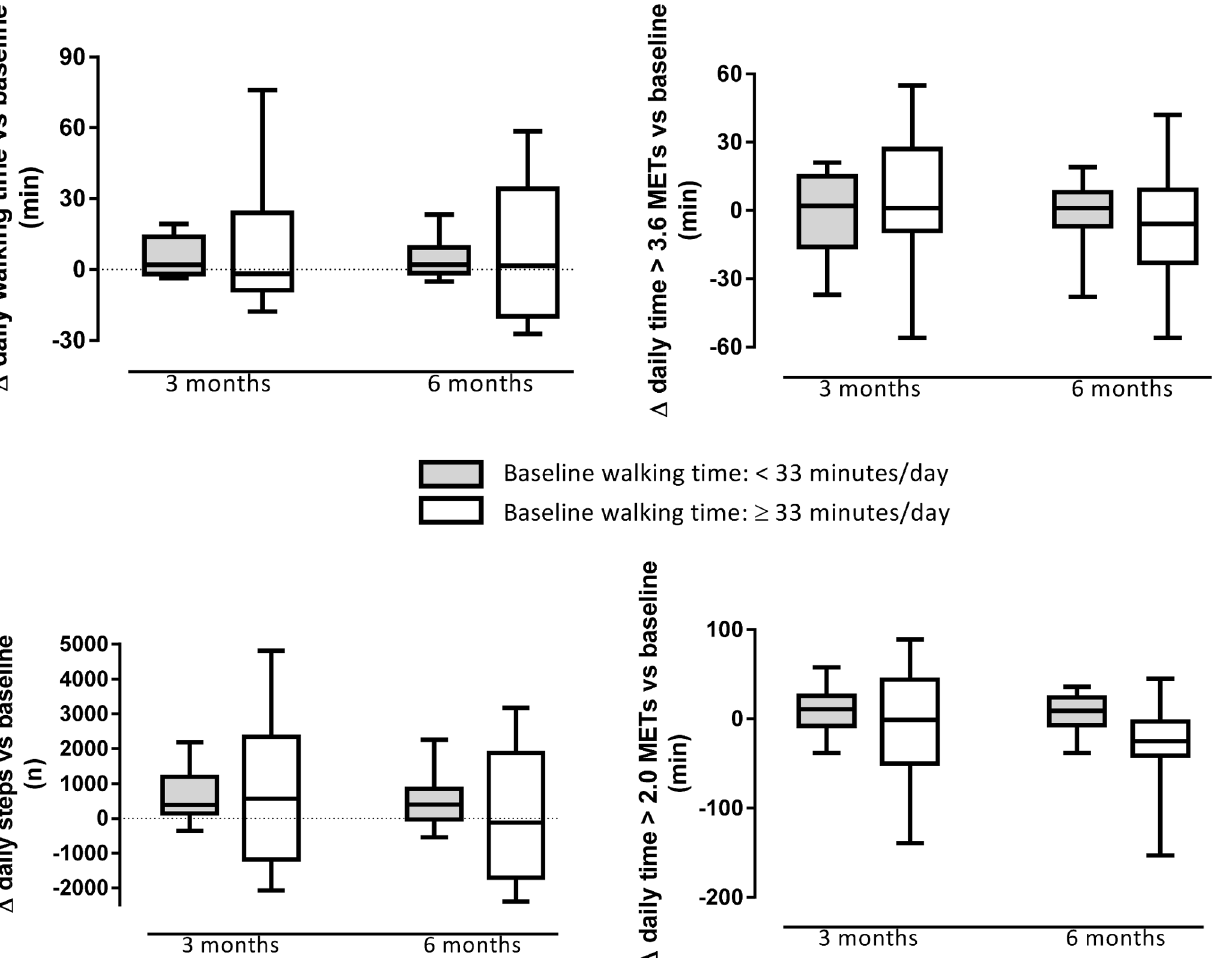
Fig 3. Absolute changes in daily time spent walking, daily steps, daily time spent in at least moderate intense activities ( > 3.6 metabolic equivalents) and at least mild intense activities ( > 2.0 metabolic equivalents) after three months (3m) and after six months of rehabilitation (6m) in active and inactive patients at baseline. A median split of baseline physical activity level is performed for each variable. Data are analysed using mixed models including daylight time as covariate. Box plots indicate median, quartile 1 and 3 and percentile 10 and 90. No Interaction effects (p < 0.05) between baseline physical activity and time were